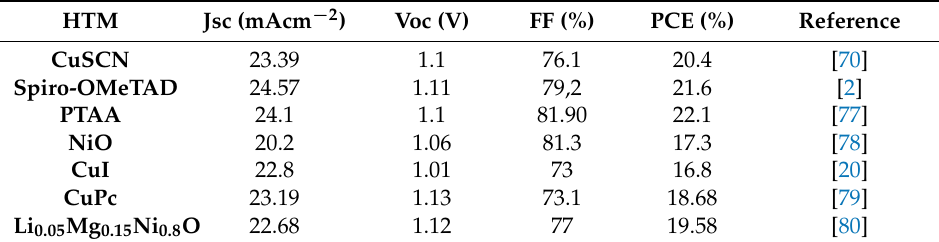
Table 6. Comparison of efficiency of CuSCN-based PSC with other HTMs.